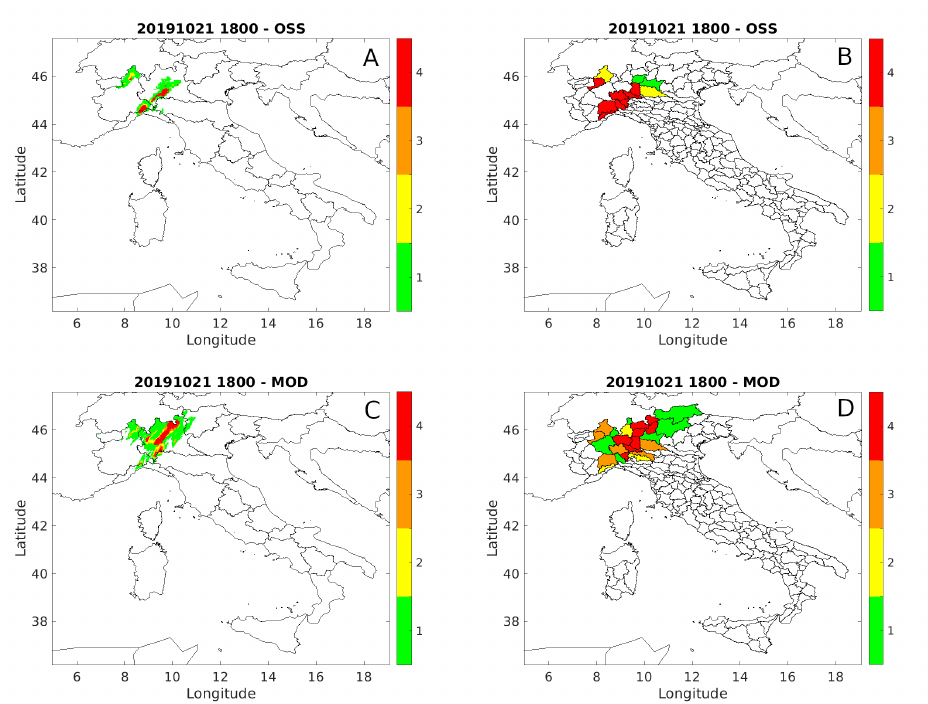
Figure 14. Scenario generated for the 21 October 2019 event at 18 UTC for the next 6 h. Panels ( A , B ) refer to observed scenario, panels ( C , D ) to the modeled